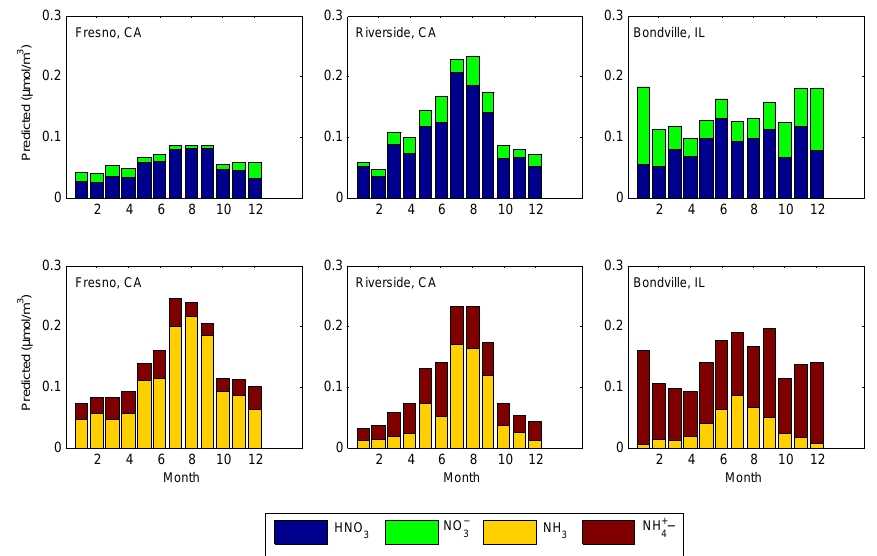
Fig. 8. Predicted 2009 monthly mean concentrations of gas-phase nitric acid, nitrate aerosol, gas-phase ammonia, and ammonium aerosol at selected sites. Note that gas-particle thermodynamic equilibrium is calculated to hold over each 20min time step of the model. The monthly mean concentrations presented in this figure represent an average of the individual 20-min equilibria over all the hours of each month, and thus do not satisfy gas-particle equilibrium in the